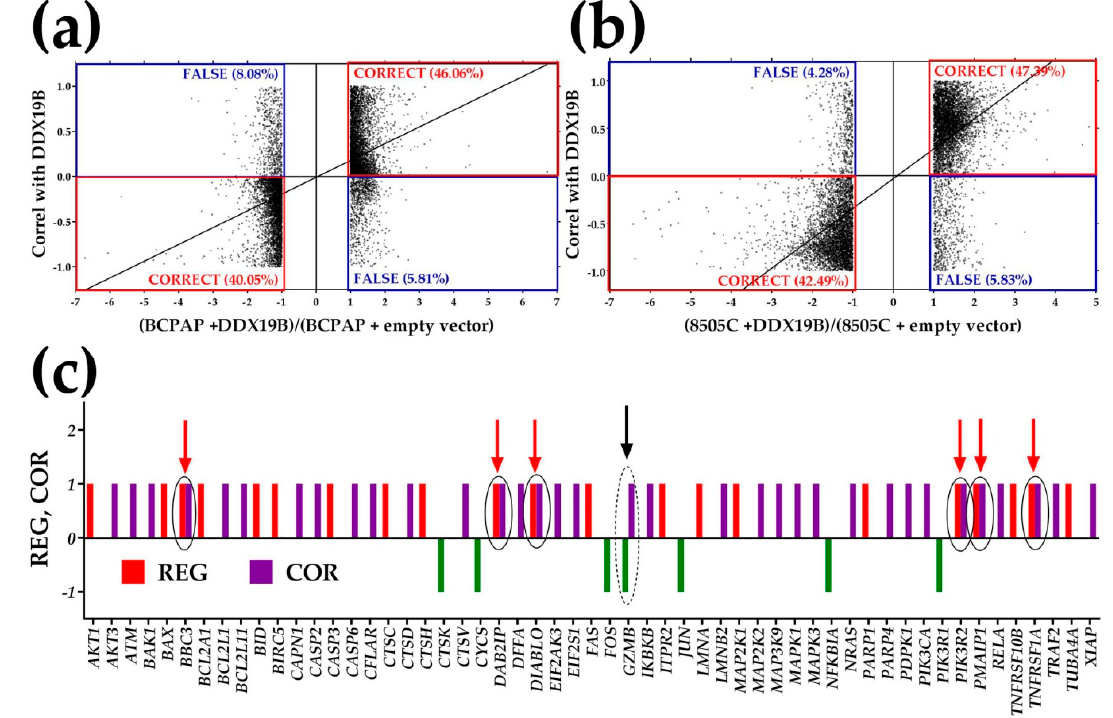
Figure 7. Prediction of the ripple effects of experimental gene regulation. ( a ) Expression coordination with DDX19B in untreated BCAP cells accurately predicts 86.11% (40.05 + 46.06) the type of the expression regulation in BCAP cells stably transfected with DDX19B ; ( b ) Expression coordination with DDX19B in untreated 8505C cells accurately predicts 89.88% (42.49 + 47.39) of the type of the expression regulation in 8505C cells stably transfected with DDX19B ; ( c ) Predicted regulation (1 for up-regulation and − 1 for down-regulation) of apoptotic genes in PTC following experimental overexpression of SPINT2. REG = significant (1 = up-regulation, − 1 = down-regulation). COR = significant expression synergism. Only the regulated genes in the untreated PTC and those expected to be regulated in treated PTC are represented. Red arrows indicate combined effect in treated tumor of regulation and expression synergism in untreated PTC. The black arrow indicates the down-regulation in untreated PTC expected to be compensated by the overexpression of SPINT2.